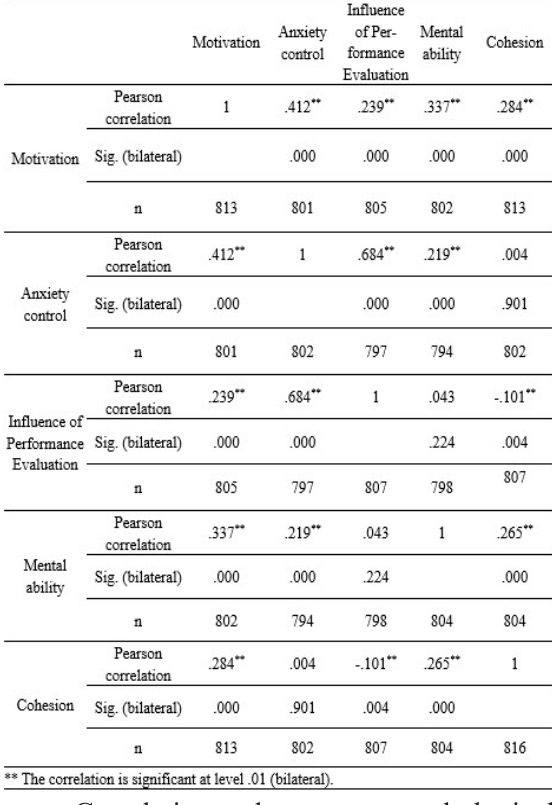
Table 6. Table of Correlations of the psychological dimensions of the